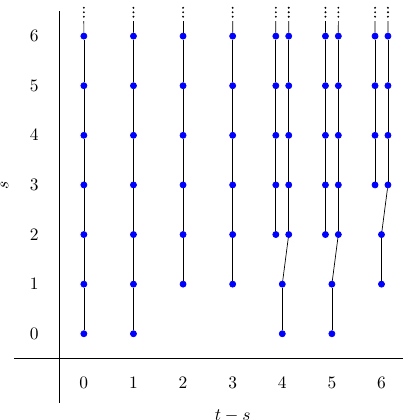
Figure 9: The Adams chart for H • ( B ( (cid:90) / 2 m )) 2 ξ ) .